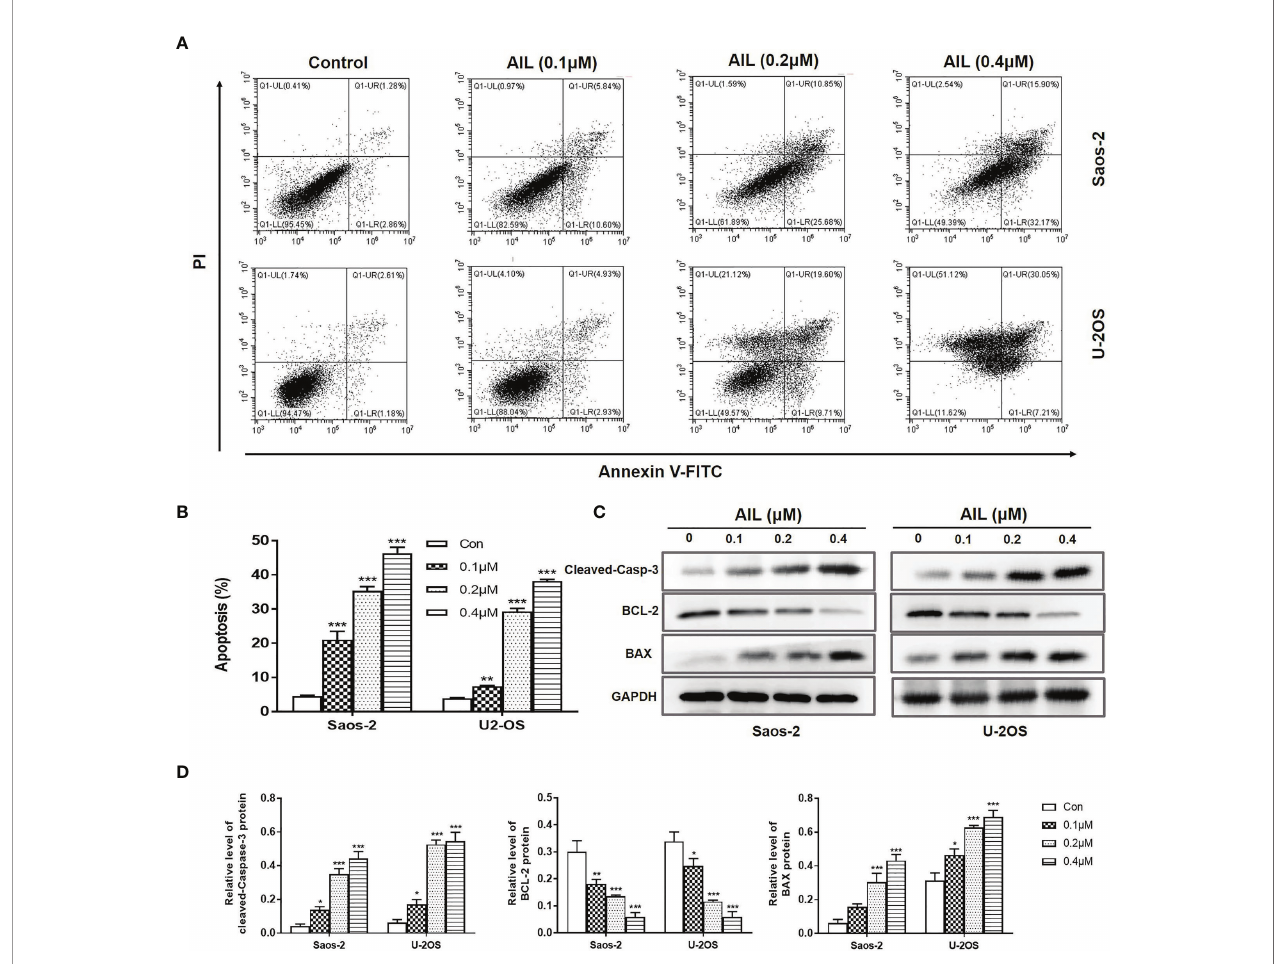
FIGURE 3 | AIL induced apoptosis in OS cells. (A) Saos-2 and U-2OS cells were, respectively, treated with AIL at different concentrations (0, 0.1, 0.2 or 0.4 m M) for 24 h. Then cells were stained with Annexin V-FITC and PI and then subjected to fl ow cytometry analysis of cell apoptosis. (B) Data of the percentage of apoptosis at various concentrations were pooled from (A) . (C) Apoptosis protein analysis. The protein levels of cleaved-Caspase-3, BCL-2 and BAX was determined by Western blot assay. (D) The protein levels were evaluated by ratio values quanti fi ed from protein bands of each marker versus GAPDH (* P < 0.05, ** P < 0.01, *** P < 0.001 compared with the